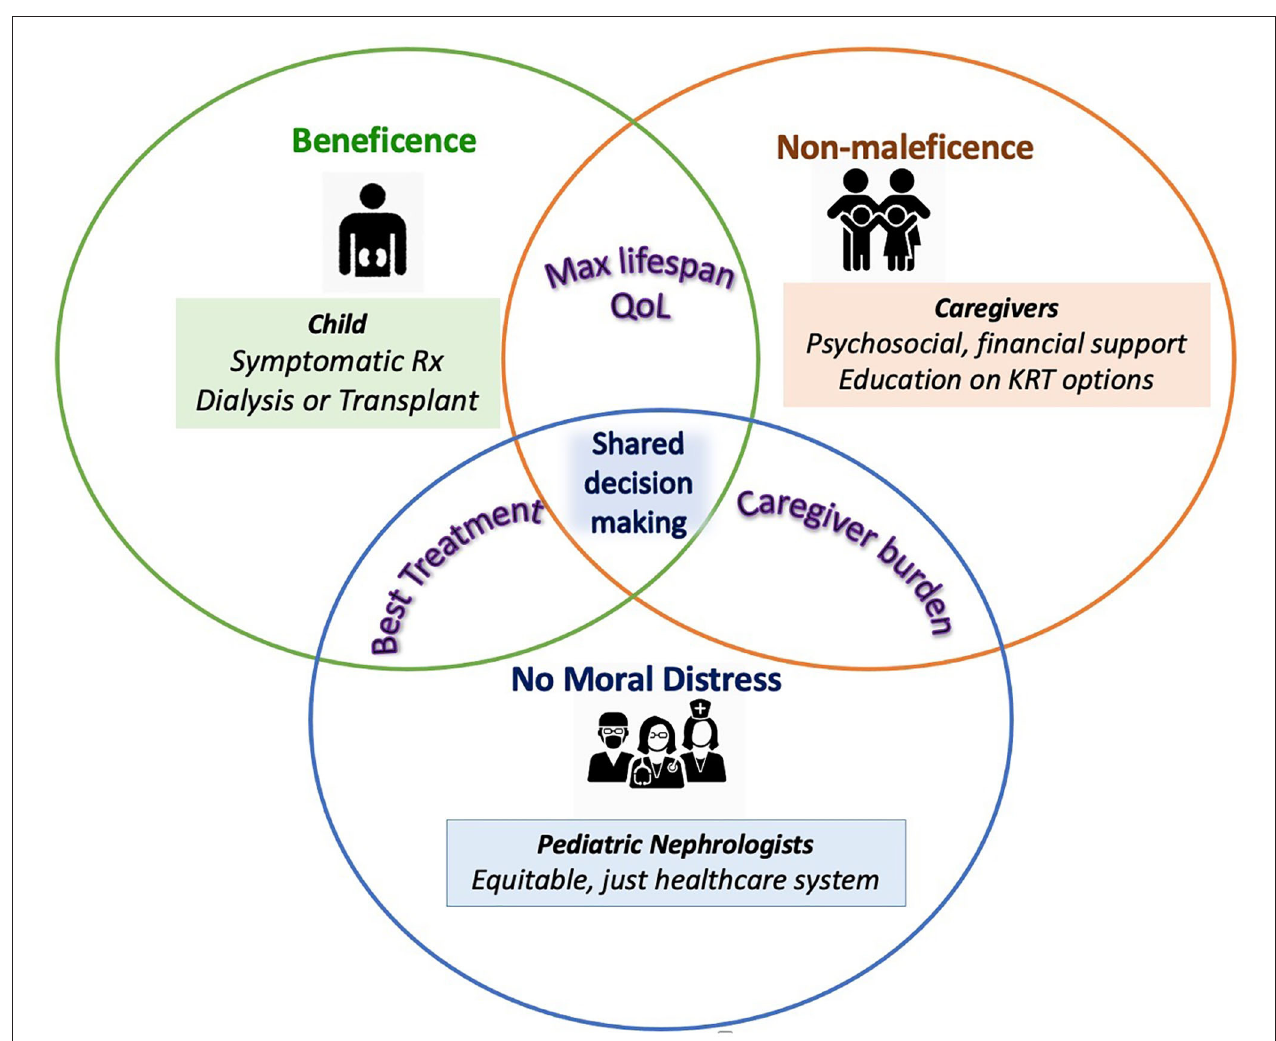
FIGURE 1 | Ethical considerations in kidney failure care for children. Each circle represent stakeholders in pediatric kidney failure care—the patient, caregivers and the healthcare team with their key clinical and ethical needs in colored text and boxes. The key interests of each stakeholder with regards to the other are represented in the overlap of their respective circles. Potential targets to support achieving these interests and overcoming ethical challenges are listed in each stakeholder’s domain. As a central clinical and ethical requirement, shared decision-making is at the center of pediatric kidney failure